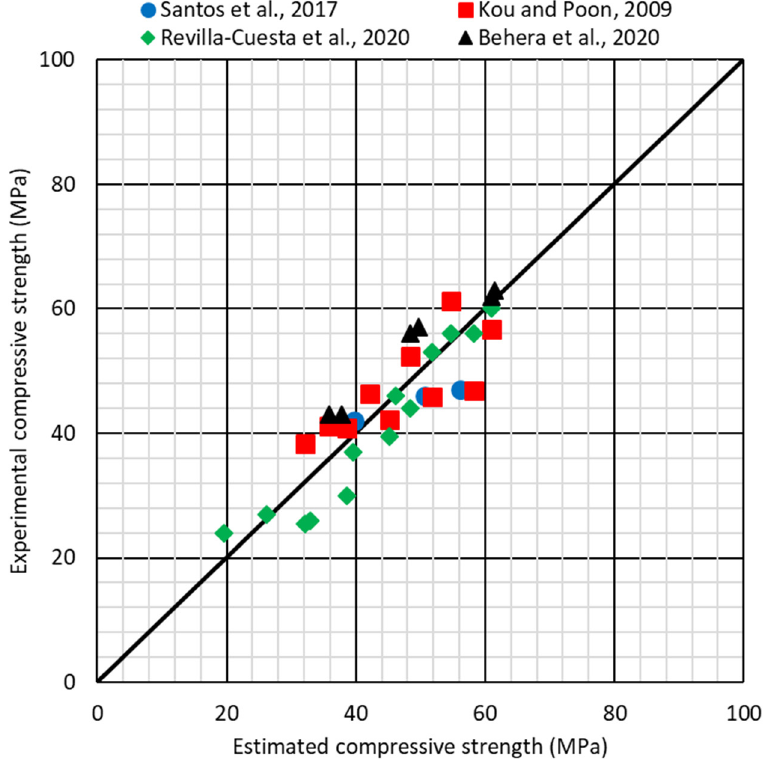
Figure 9. Validation of the model developed (Equation (3)) throughout other similar studies